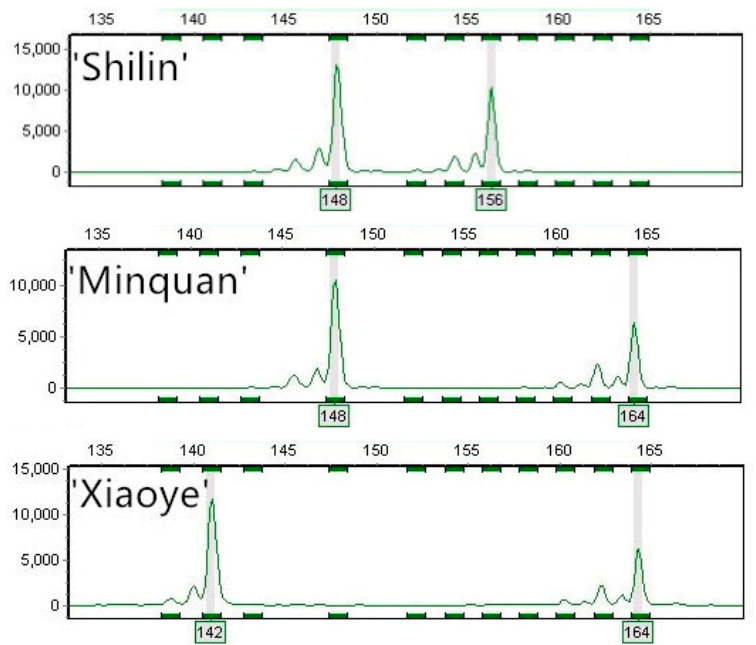
Figure 4. Fragments amplified by Rply3 primer pairs for the black locust cultivars ‘Shilin’, ‘Minquan’ and ‘Xiaoye’ (Sized by GeneMarker 1.8.0).